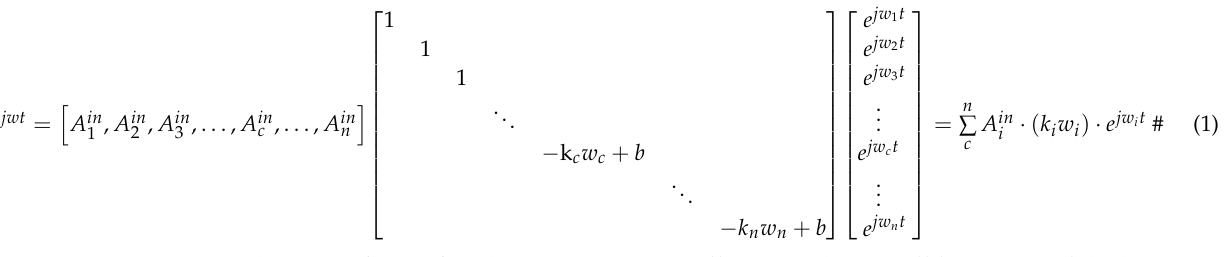
where T c = k c w c + b is the transmission coefficient at the cut-off frequency of the low-pass filter. The low-pass filter in Equation (1) is an ideal filter with transmission coefficients equal to one when the incident frequencies are lower than the cut-off frequency. This means that the frequency components in the range of 0~ w c pass through the surface crack without any loss. Therefore, the surface crack is seen as an ideal low-pass filter by Equation (1). To analyze Equation (1) in detail, assuming that the frequency band ranges from 0 to ~5 MHz, the low-pass filters under the condition that the value k is − 1 and b ranges from 4 to 4.5.